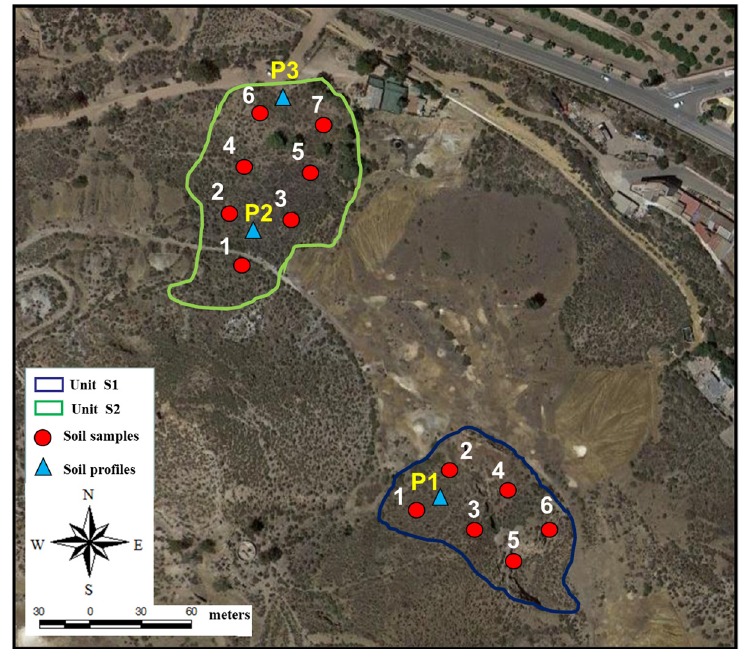
Figure 3. Study area and sampling points.